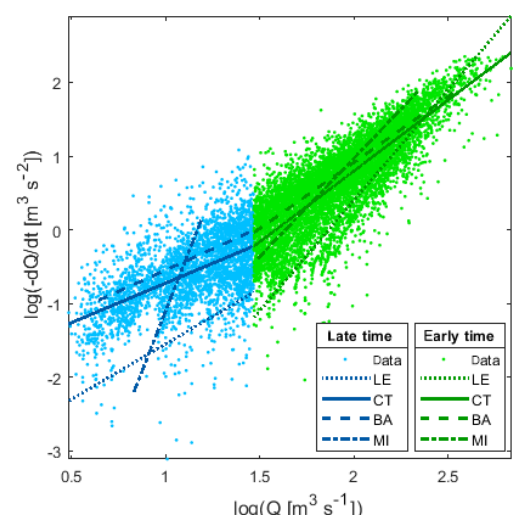
Figure 3. Recession analysis for Lookout Creek to aid in the com- parison of four different fitting methods and the dependency on pa- rameter estimation shown visually (lower envelope – LE, central tendency – CT, and binning average – BA) and individual reces- sions parameters (median individual recession – MI). Depending on the fitting method, the parameter estimation for a and b will be different.